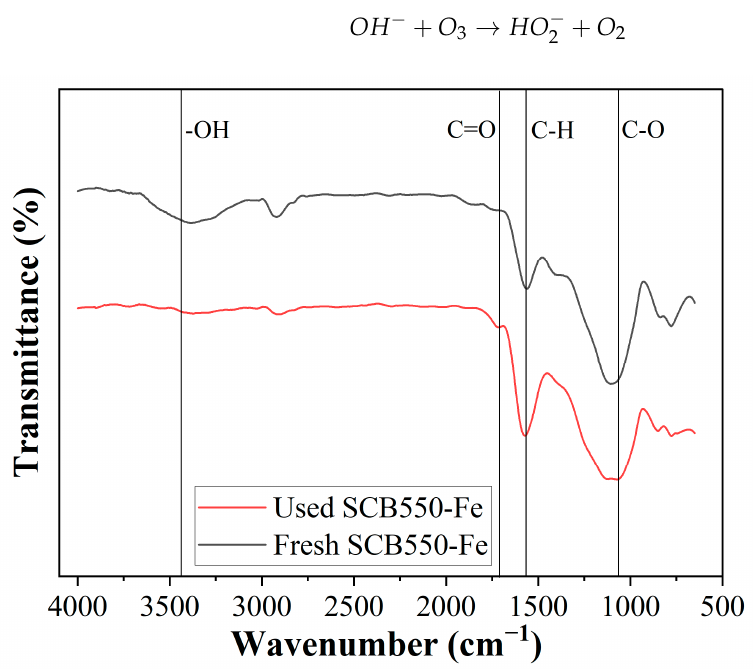
Figure 7. Comparison of the FTIR spectra of fresh and used SCB550-Fe.